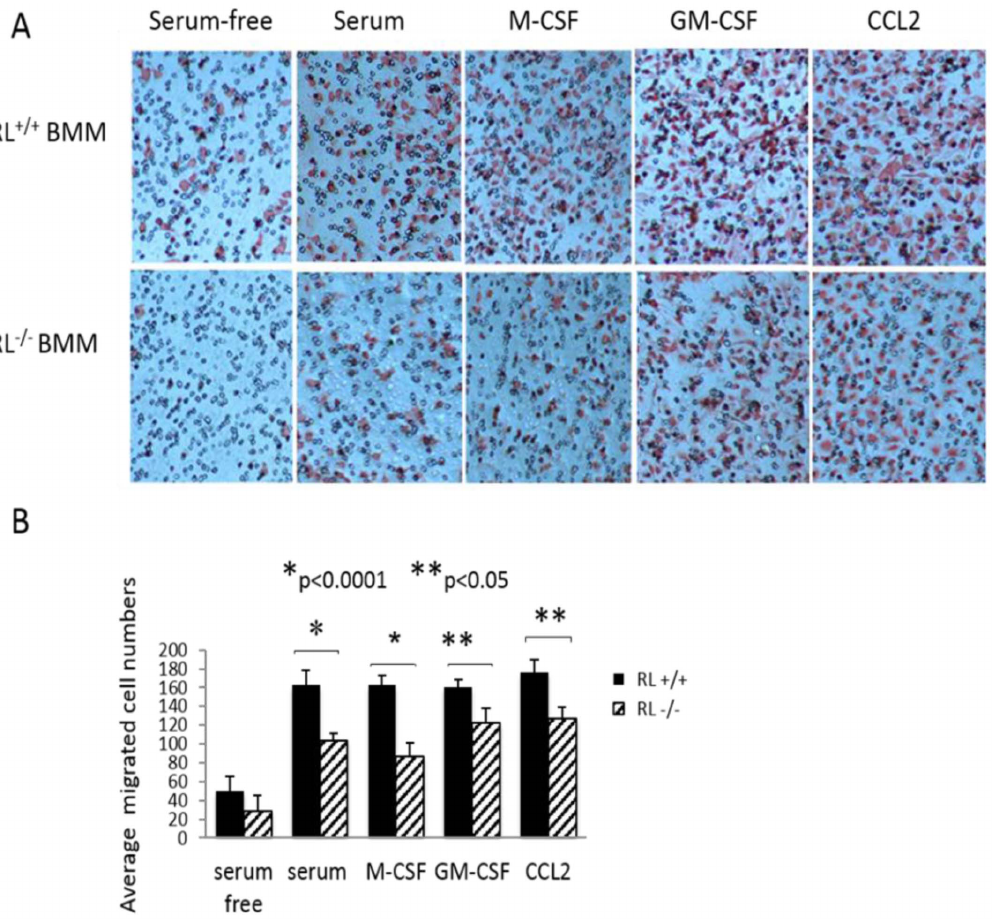
Figure 1. Effect of RNase L on macrophage migration. (A) RNase L deficient and wild type BMMs were seeded to the upper chambers of 8 m m Transwells (black) precoated with 20 m g/ml fibronetin for overnight at 4 u C. In the lower chambers, serum-free DMEM, serum-free DMEM with 10% FBS or 100 ng/ml of M-CSF or GM-CSF or CCL2 were added respectively, and the cells were allowed to migrate at 37 u C overnight. The cells on the filter side of the up chambers were cleaned with a cotton swab and the migrated cells (red) were fixed by 10% formalin for 5 min, followed by staining with eosin. The unstained grey circles were the pores of the filter. The experiment was repeated three times in duplicate for each treatment. The photos were from one of the three experiments. (B) The cell numbers were averaged from five fields per transwell in duplicate and present as Mean 6 SD. *p , 0.0001, **p , 0.05.